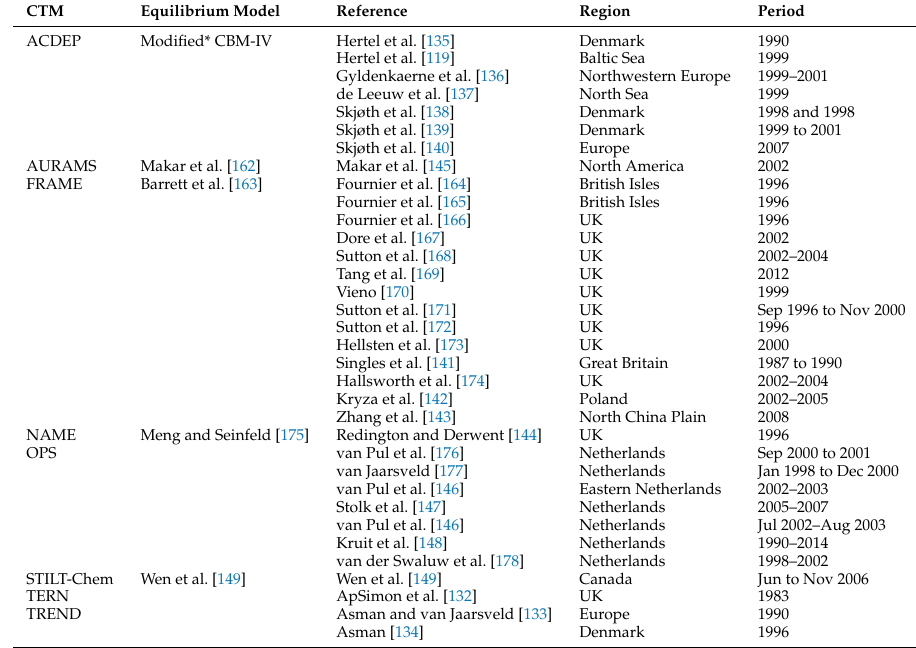
See Table S2 for details of Equilibrium Models. Abbreviations: CTM: Chemical Transport Model, CHIMERE:, CMAQ: Community Multiscale Air Quality, DAMOS: Danish Ammonia MOdeling System, EMEP: European Monitoring and Evaluation Programme, GEOS-Chem: Goddard Earth Observing System - Chemistry, LOTOS-EUROS: LOngTerm Ozone Simulation - EURopean Operational Smog, MATCH: Multi-scale Atmospheric Transport and Chemistry, PMCAM x :, TM5: Tracer Model 5. * Modification of the Carbon Bond Mechanism IV reaction mechanism with a scheme for NH 4 NO 3 and (NH 4 ) 2 SO 4 by Zlatev [161]. Table 4. Some modeling studies of atmospheric [NH 3 ] using Lagrangian chemical transport